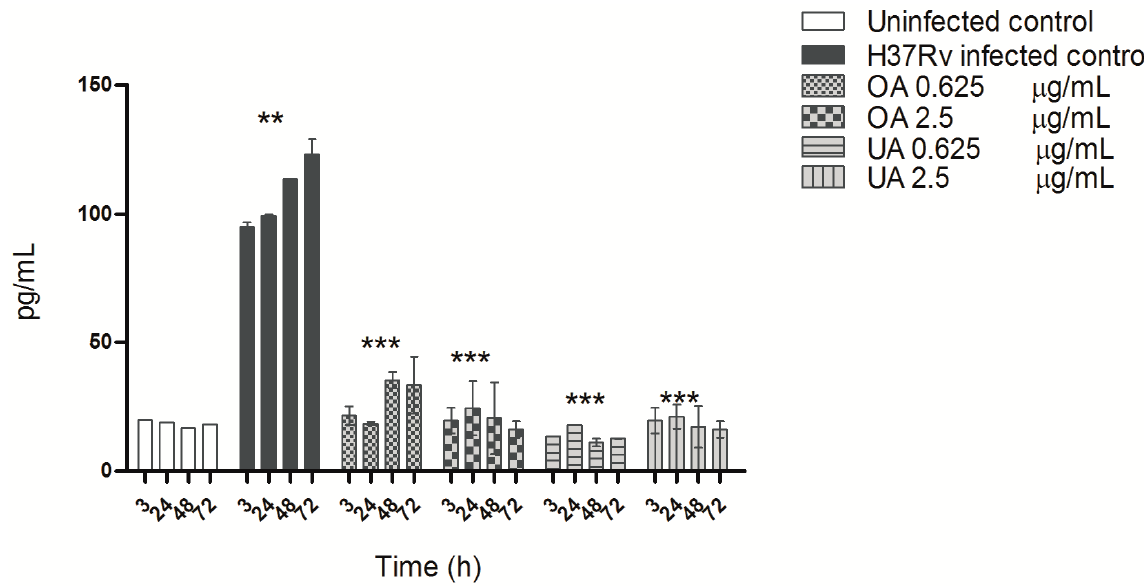
Figure 5. TGF- β production by macrophages infected with M. tuberculosis H37Rv and treated with OA and UA. Macrophages infected with strain H37Rv were treated with different concentrations of OA and UA for 3, 24, 28 and 72 h post-infection. TGF- β was quantified in cell supernatants from uninfected, infected and treated macrophages using a commercial ELISA kit. The data are presented as means ± SD from three different experiments. Statistically significant differences indicated are when infected and treated cell values (OA, UA), were compared with infected cells (H37Rv infected control) (*** p < 0.001), or when non-infected cells (Uninfected control) where compared with infected cells (H37Rv infected control) (** p <